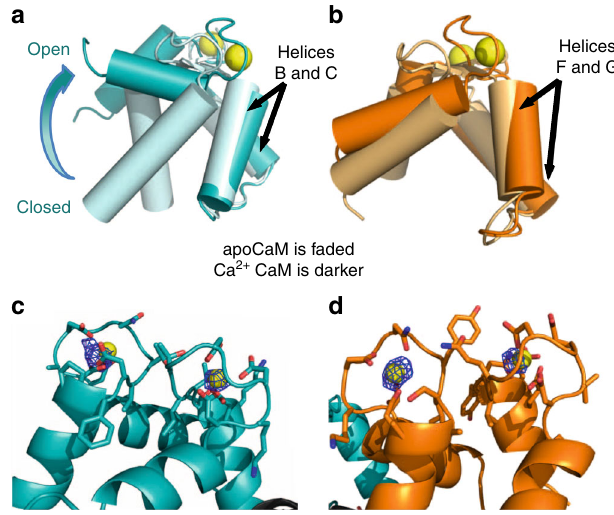
Fig. 3 Structural overlap of the N-lobe and C-lobe of CaM bound to Na V 1.4 CTerm. a CaM N-lobes aligned by helices B and C (residues 32 – 55)